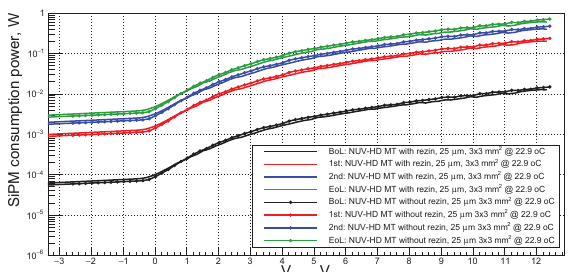
Figure 7: Power consumption by the SiPM